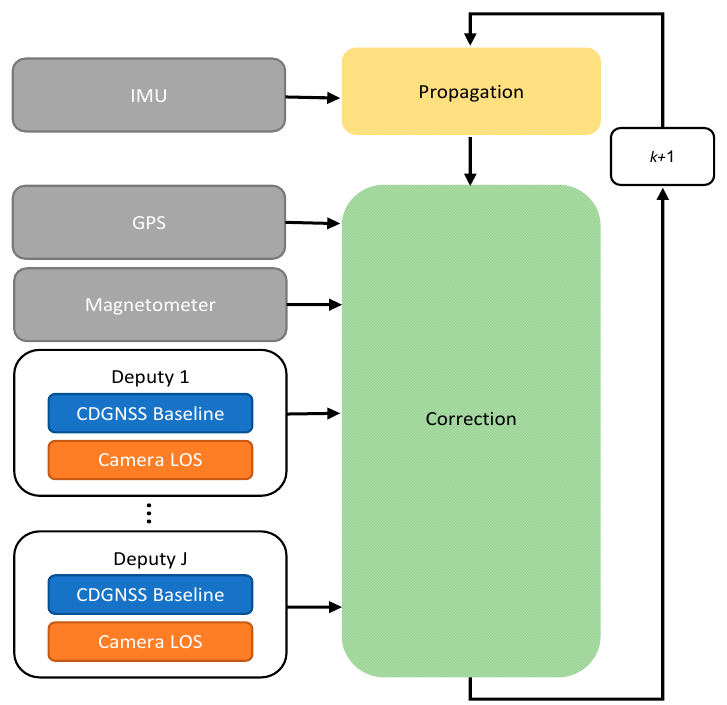
Figure 2. Cooperative navigation filter. Non cooperative measurements are depicted in gray. For each deputy CDGNSS and vision, measurements are depicted respectively in blue and orange.